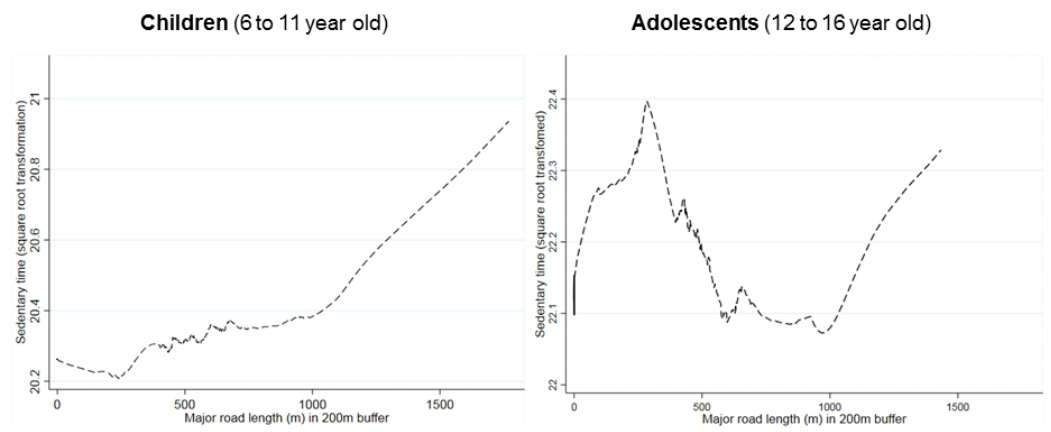
Figure 3. Association between time spent sedentary in the weekend and main street density by age-group. P for interaction = 0.01, Coefficient for children: 0.03 (0.0; 0.07); Coefficient for adolescents: − 0.2 ( − 0.7; 0.2).